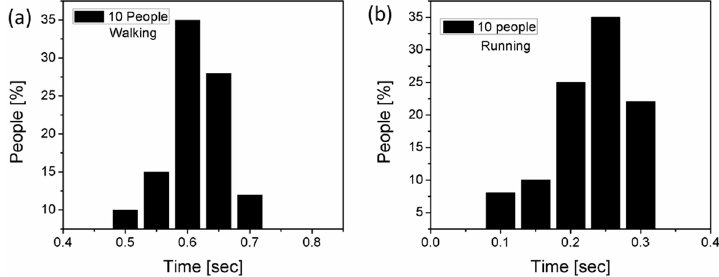
Figure 9. ( a ) “Walk” data of 10 people. ( b ) “Run” data of 10 people.